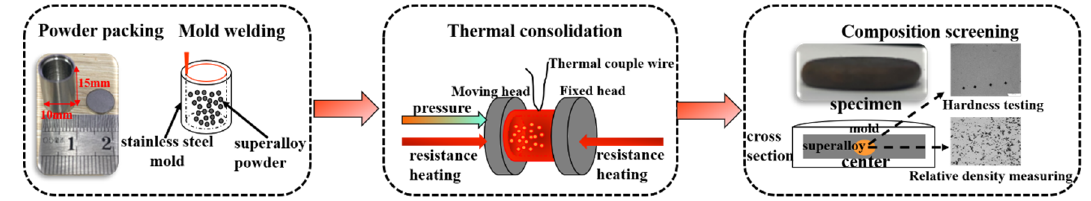
Figure 1. Schema of the thermal consolidation process.